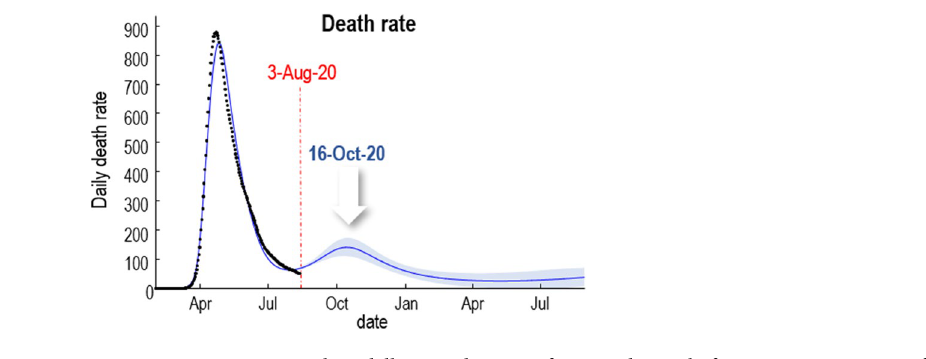
Figure 5. Dynamic causal modelling predictions of a second wave before any increase in confirmed cases in early August. This figure is taken from an internal report on the causes of second waves 13